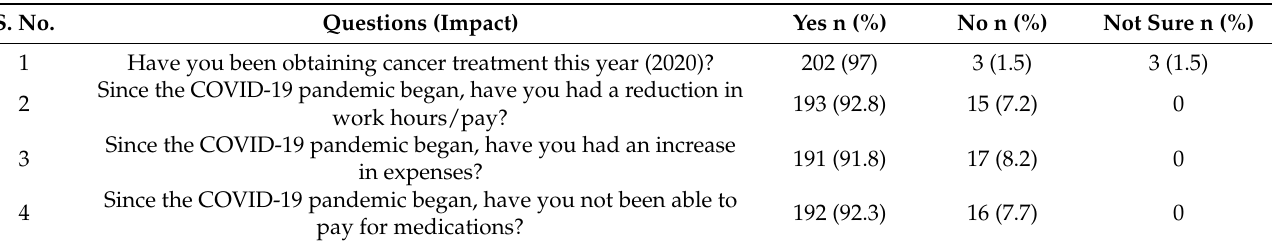
Table 5. Participants’ views on COVID-19